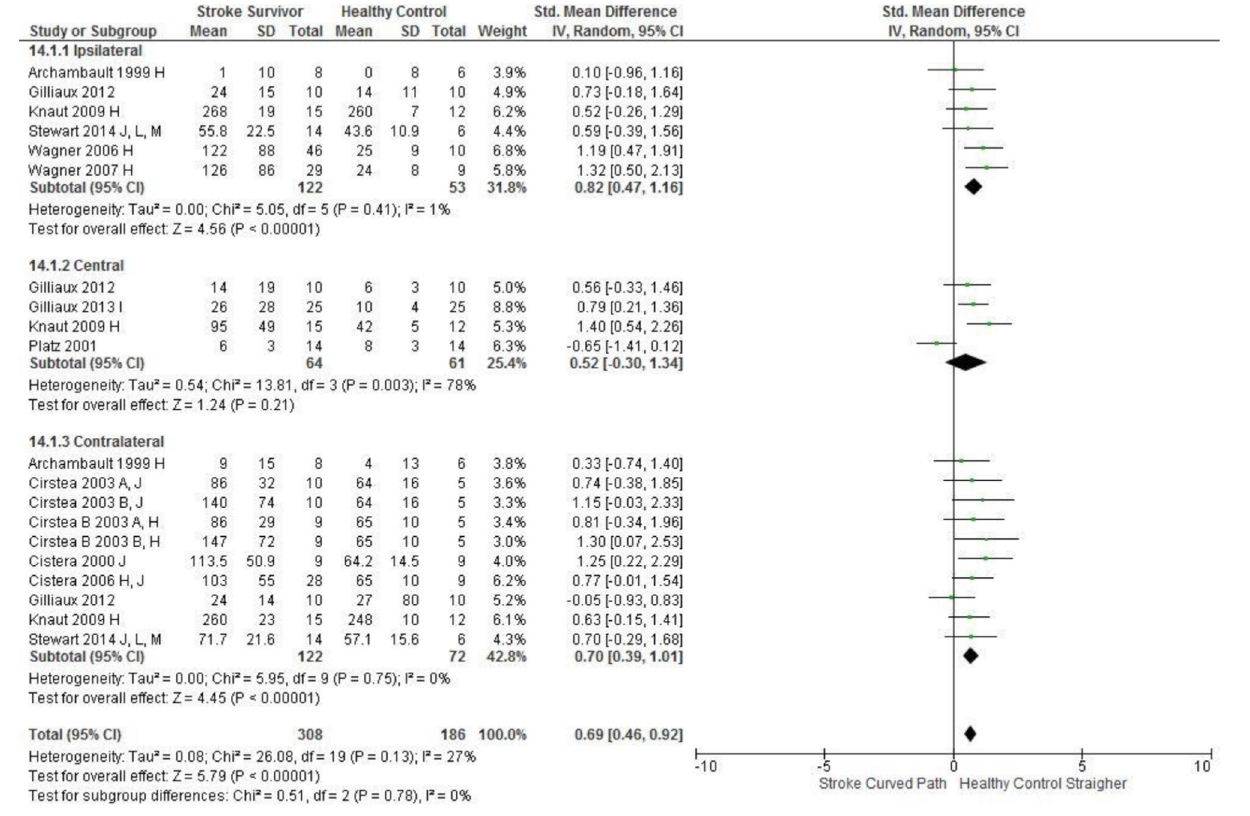
FIGURE 8 | The standardized mean difference (SDM) of accuracy (mm) in the ipsilateral, central, and contralateral workspace. A, mild motor impairment; B, moderate motor impairment; C, bilateral task; H, fast speed; I, robotics; J, reaches without vision; M, virtual